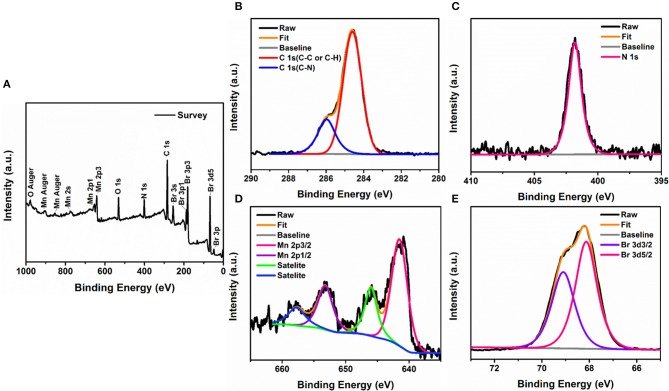
(A) XPS survey spectra of (1-mPQBr)2MnBr4. High-resolution XPS spectra of (B) C 1s, (C) N 1s, (D) Mn 2p, and (E) Br 3d.